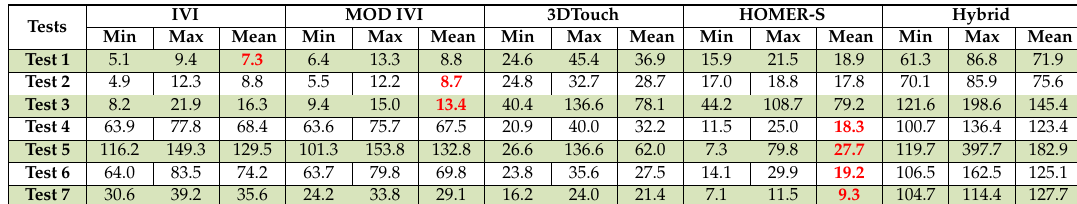
Table 1. Phase One completion time (seconds) with highlight of shortest completion